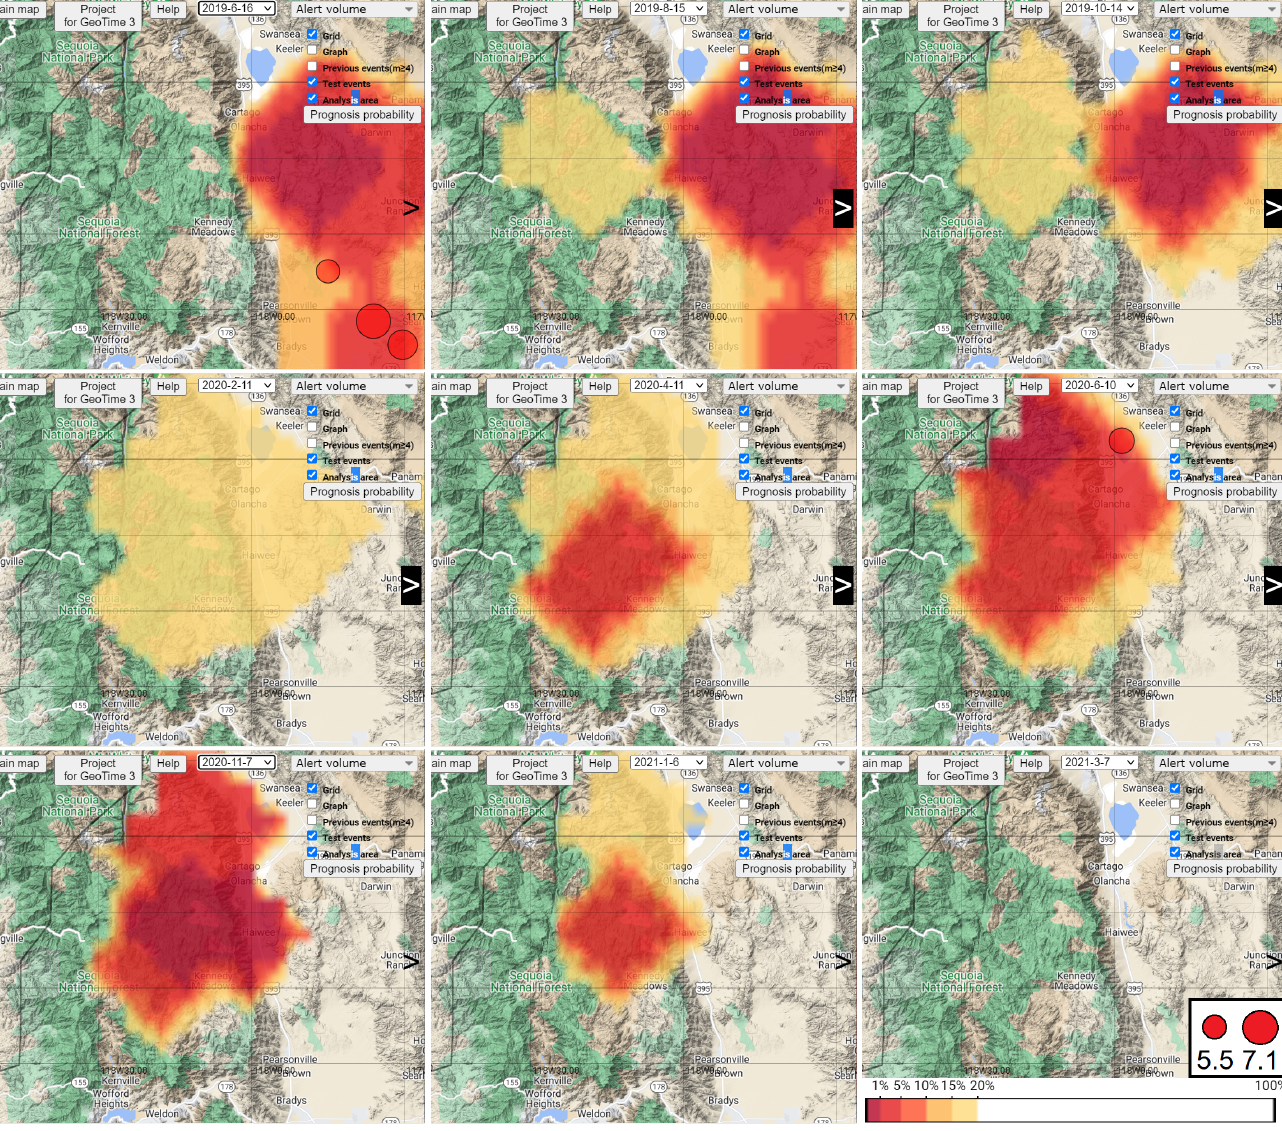
Figure 3. Sections of the alarm field at forecast intervals: Line 1 [16 June 2019–16 July 2019),